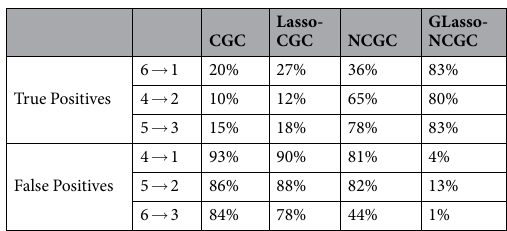
Table 3. Comparison of discovery rate of representative edges extracted from true adjacency matrix in BRN